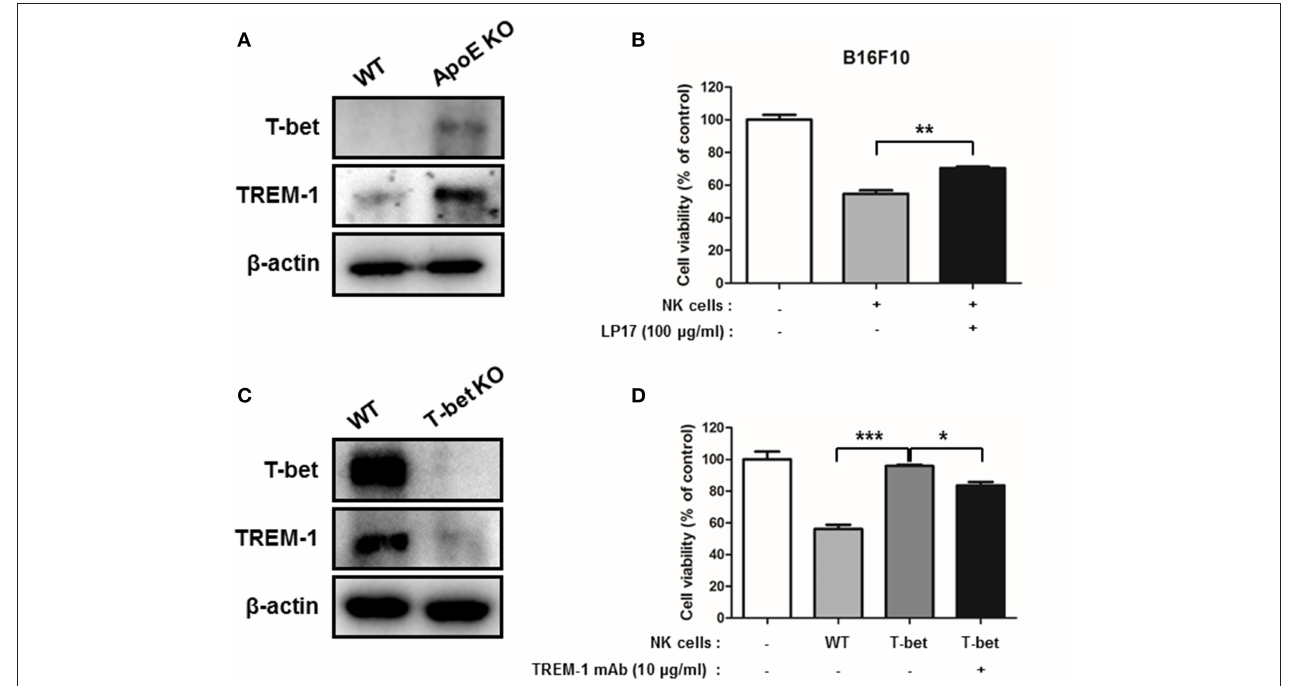
FIGURE 6 | TREM-1 is involved in NK-cell mediated cytotoxicity. WT and ApoE KO NK (A) or T-bet KO NK (C) cell lysates were analyzed by Western blotting. NK cell cytotoxicity was determined using LDH assay co-cultured with control WT, LP-17 treated WT NK (B) or with control WT, non-treated or TREM-1 mAb treated T-bet KO NK cells (D) and B16F10 target cells for 4h (1 × 10 4 cells/well) ( n = 3). E:T ratio is 4:1. * p < 0.05, ** p < 0.01, and *** p <